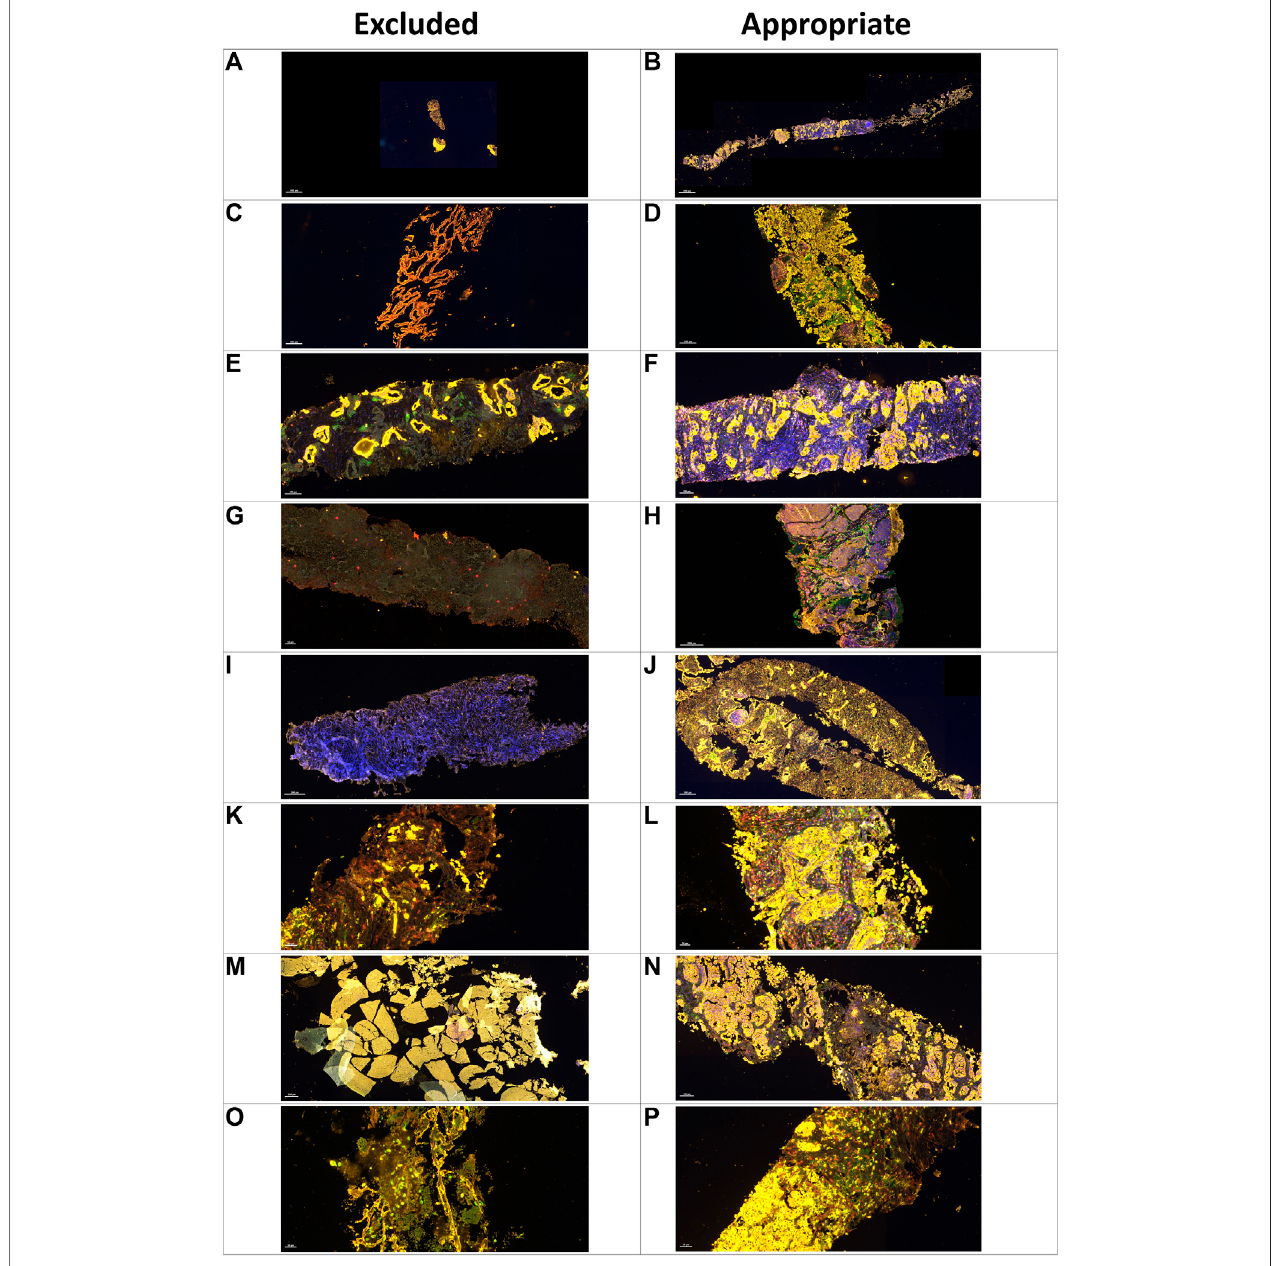
FIGURE 4 | Microphotographs of representative examples of excluded and included core needle biopsies in multiplex immuno fl uorescence slides using digital image analysis assessment for pathology quality control. Excluded examples ( Left column ) compared with samples considered appropriate for image analysis ( right column ). A small sample (A) compared with a large sample with adequate amount of tumor content in yellow (B) . Sample without malignant cells and with only normal tissue in yellow (C) compared with nets of malignant cells in yellow (D) . Nets of malignant cells in yellow in the middle of extensive fi brotic areas with lack of in fl ammatory cells (E) compared with a sample with a large amount of in fl ammatory cells (F) . Sample with extensive necrotic area in grayish green (G) compared with a sample without necrotic areas (H) . Sample with staining artifact showing the lack of marker expression (I) compared with another sample with adequate staining (J) . Sample with crushed cells artifact (K) compared with a sample with clear individualization of the different cells (L) . A hemorrhagic sample (M) compared with a sample withadequatetumortissue (N) .Asamplewithmostlymucinousmaterialandfewtumorcells (O) comparedwithanothersamplewitharegularamountoftumorcells (P) .